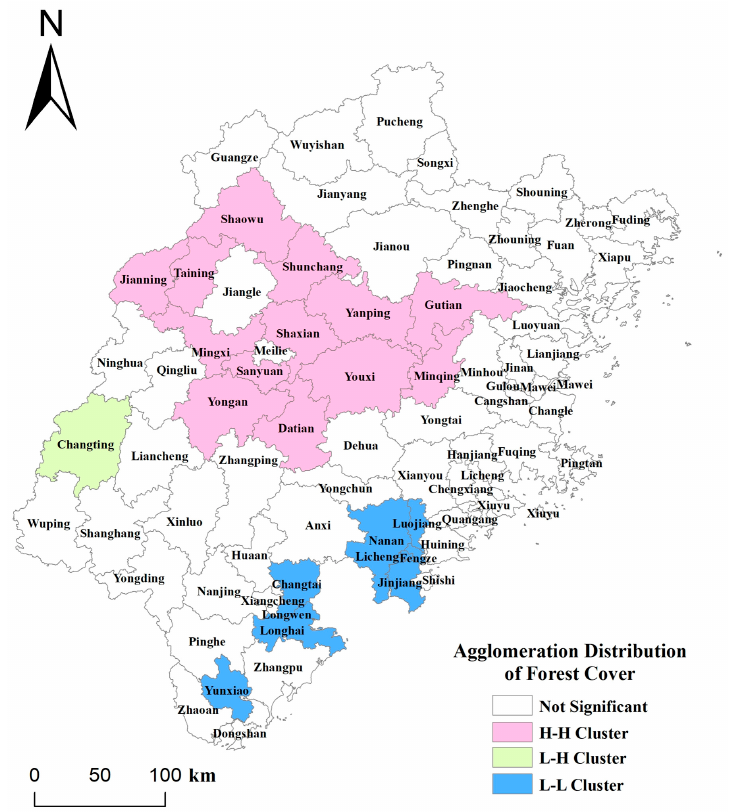
Figure 2. Spatial agglomeration distribution result of forest cover in Fujian Province in 2020.